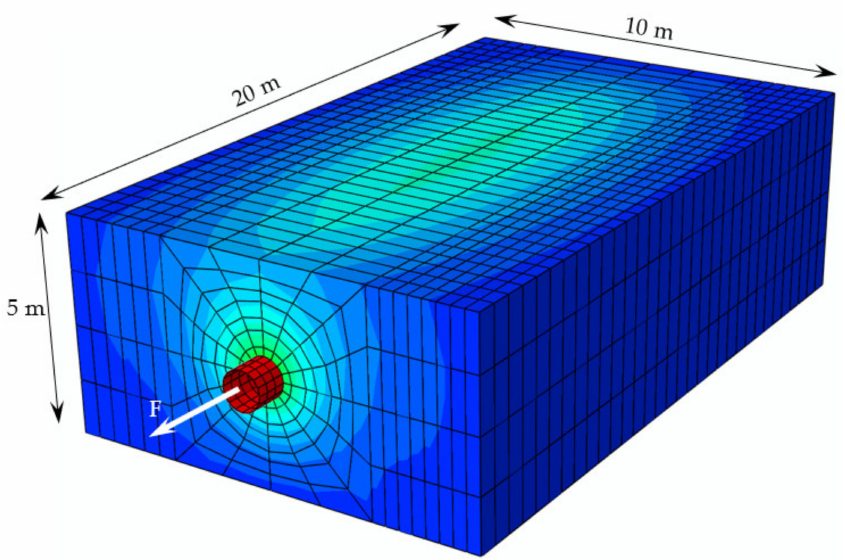
Figure 3. 3D solid model for the pull-out test of the buried pipeline (displacement contours). After verification of the 3D solid model for the pull-out test for the 0.2, 0.3, and 0.4 friction coefficient cases, the case with the 0.3 friction coefficient ( τ max = 10 kPa) was selected as the main case for this